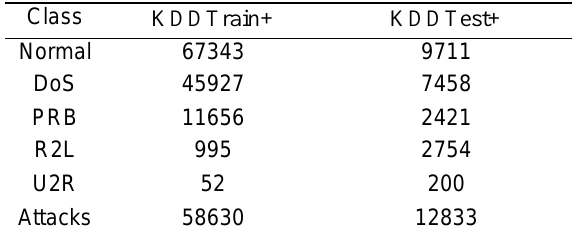
Table 5. The breakdown of the three sets of the NSL- KDD